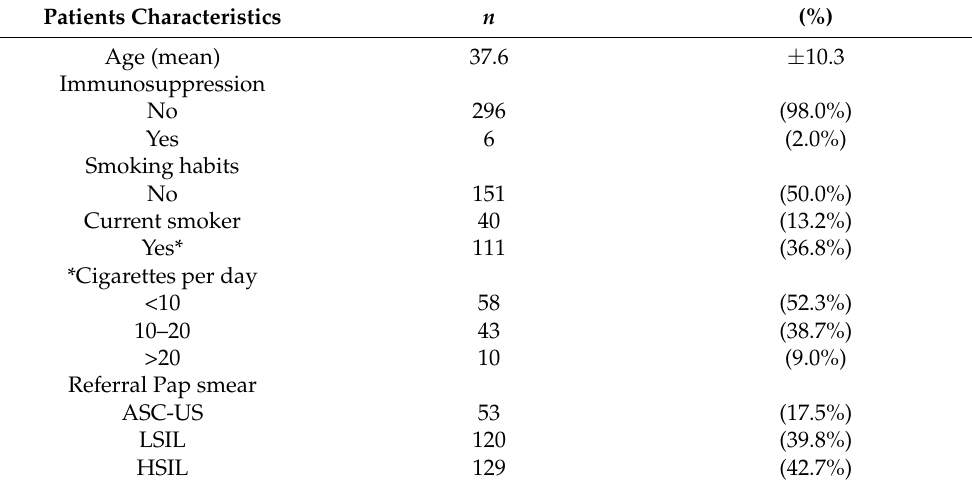
Table 1. Epidemiological information (age, immunological status, smoking habits, and referral cytology) of the 302 women included in the